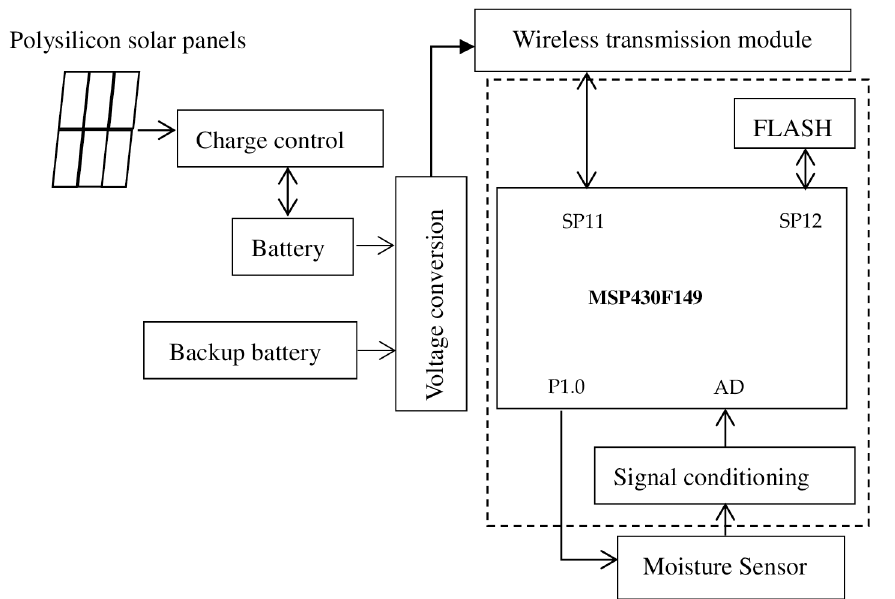
Fig 4. Schematic diagram of data acquisition and wireless